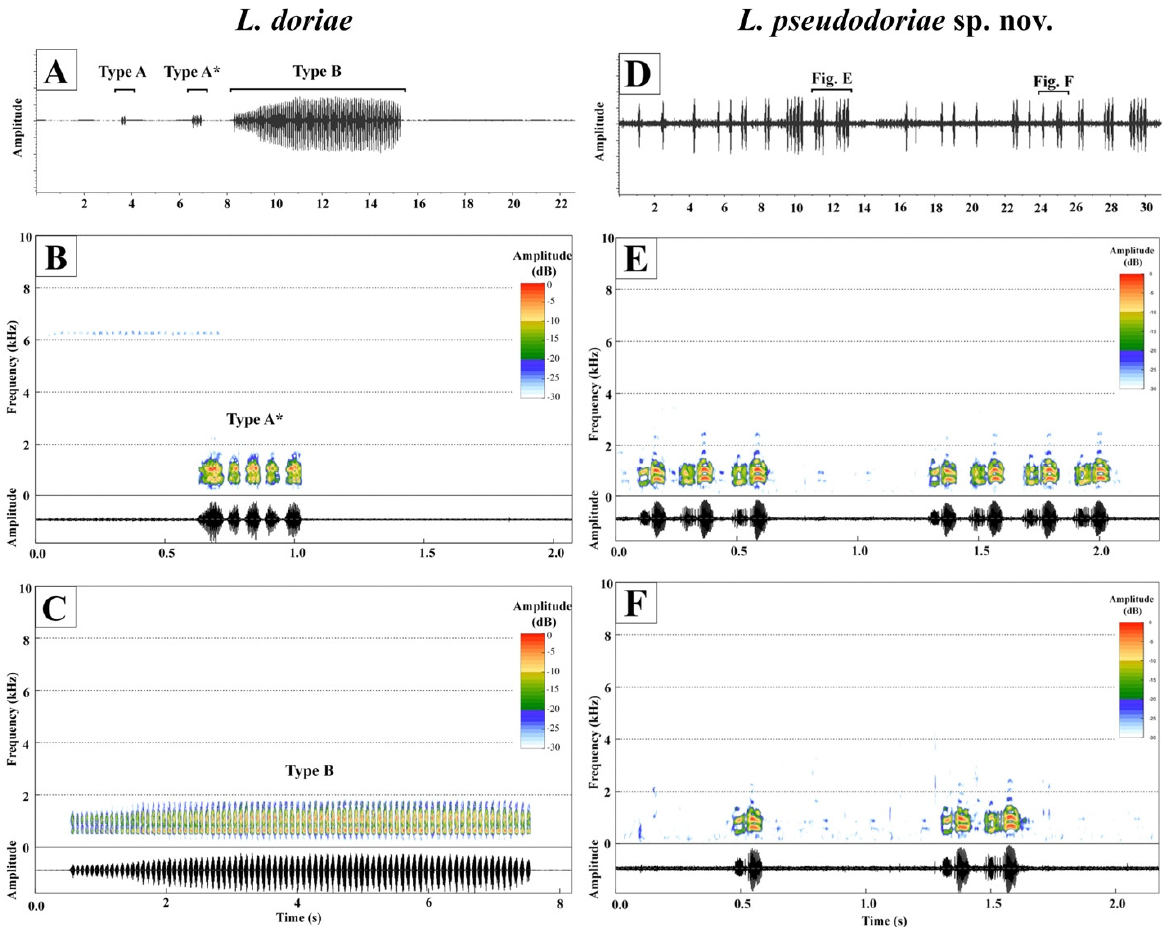
Figure 4. Comparative spectrograms and oscillograms of Limnonectes doriae (ZMKU AM 01552; A – C ) and L . pseudodoriae sp. nov . (ZMKU AM 01580; D – F ). ( A ) 22 s waveform of consecutive calls, ( B ) 2 s waveform and spectrogram of Type A call, and ( C ) 8 s waveform and spectrogram of Type B call from L. doriae . ( D ) 30 s waveform of consecutive calls, ( E ) 2 s waveform and spectrogram of three-note and four-note calls, respectively, and ( F ) 2 s waveform and spectrogram of one-note and two-note calls, respectively, from L . pseudodoriae sp. nov . Type A * in ( B ) is the enlargement of the Type A note